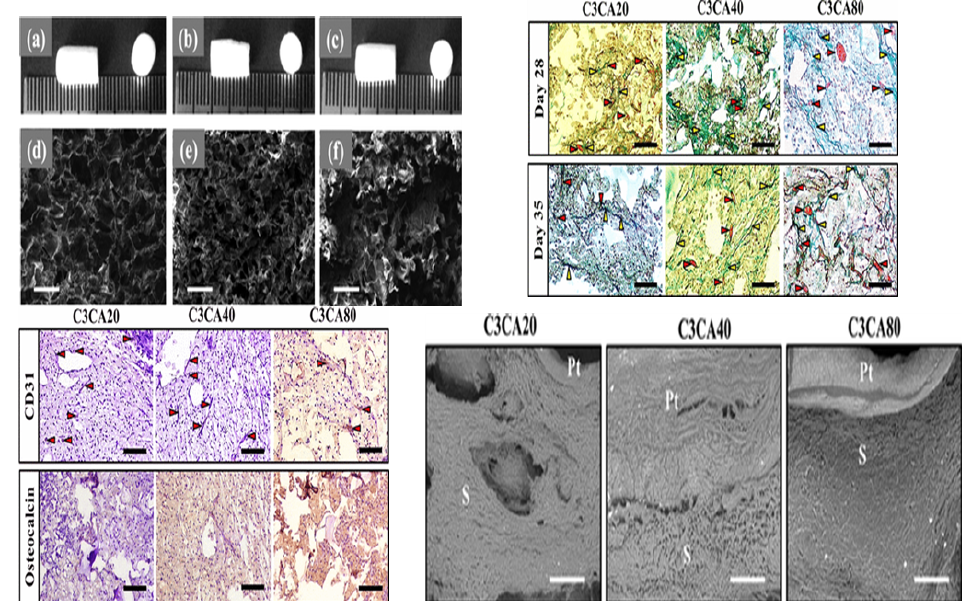
Figure 10. Fabrication of freeze-dried scaffolds via lyophilization technique using C3CA scaffolds. ( a – c ) Camera images and ( d – f ) cross ‐ sectional view of C3CA scaffolds processed at − 20, − 40, and − 80 °C depicting porous structures, and the pores were bigger in C3CA20 compared to those in C3CA40 and C3CA80. Scale bar: 100 μ m. Masson’s trichrome staining of C3CA scaffolds sections after 28 and 35 days of implantation. Red arrows depicting blood vessels; yellow arrows depicting collagen deposition. Scale bar: 100 μ m. Positive staining of CD31 verified the vascularization in the implants. The occurrence of mild staining of osteocalcin ‐ positive cells designates the unconfined cells to osteoblastic lineage. Fibrous tissue in ‐ growths into the pore spaces of implants as directed with no apparent alteration between peripheral tissues (Pt) and implant material (S). Scale bar: 500 μ m. Reprinted with permission from Ref. [166], Copyright 2018, MDPI.